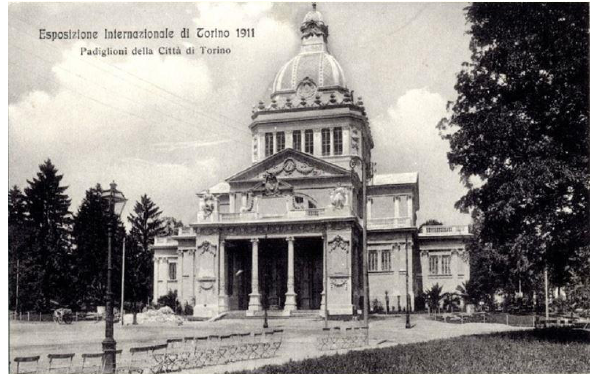
Figure 3. 1911 Postcard of the Pavilion of the City of